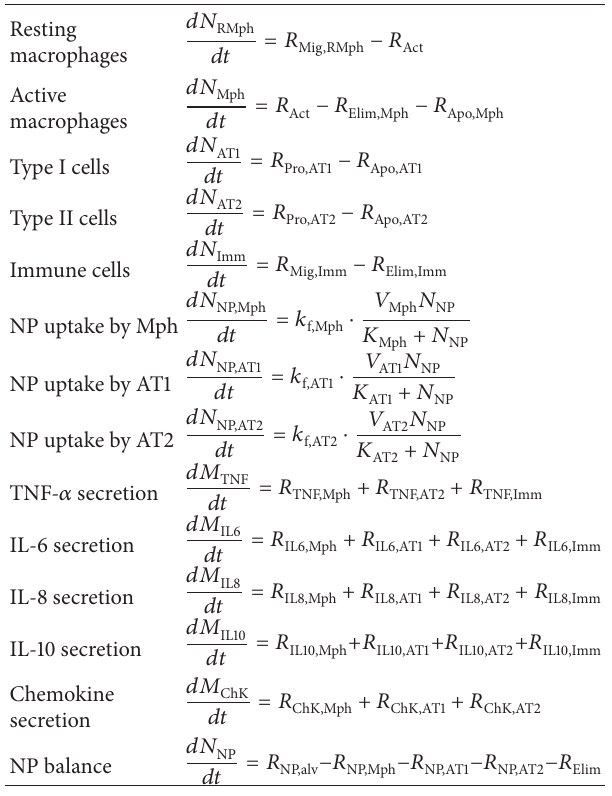
Table 4: Equations constituting the mathematical framework for a proposed in vivo cellular scale inflammatory pathway